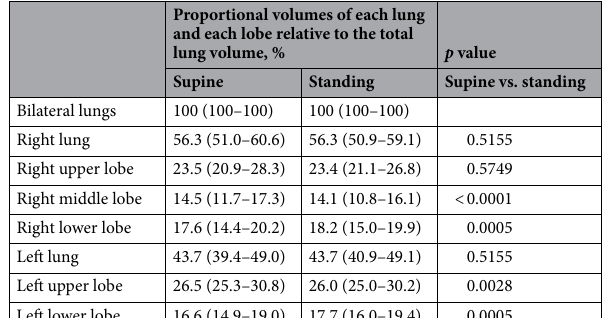
Proportional volumes of each lung and each lobe relative to the total